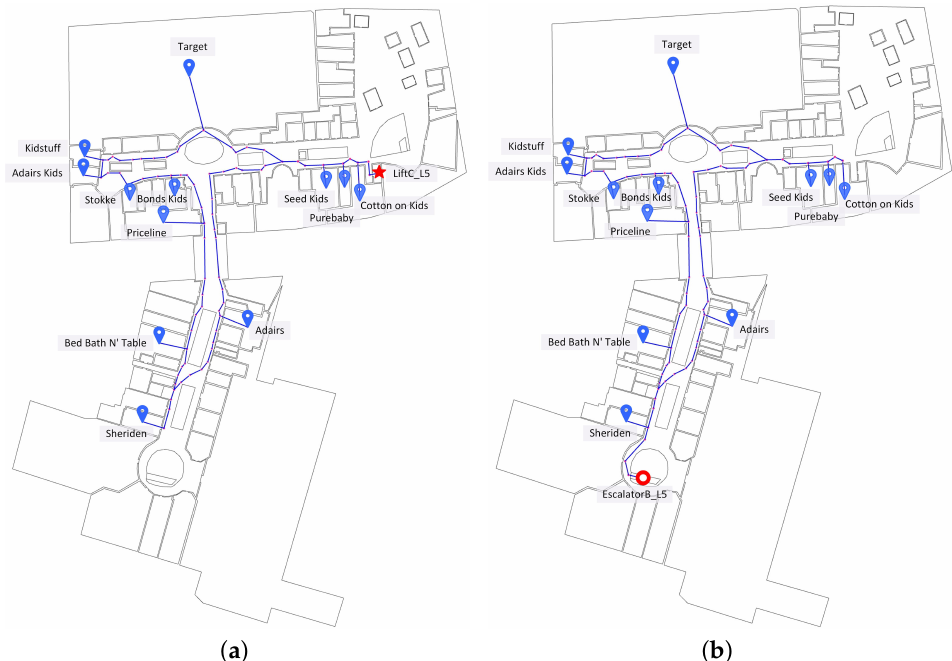
Figure 8. The ITSP path tests on the selected floor. The red star and circle represent the departure location, the blue location tags mark the shops that have stuff for kids/babies, the blue lines are the navigation paths, and the pink dots in the navigation path are the vertex of path segments.